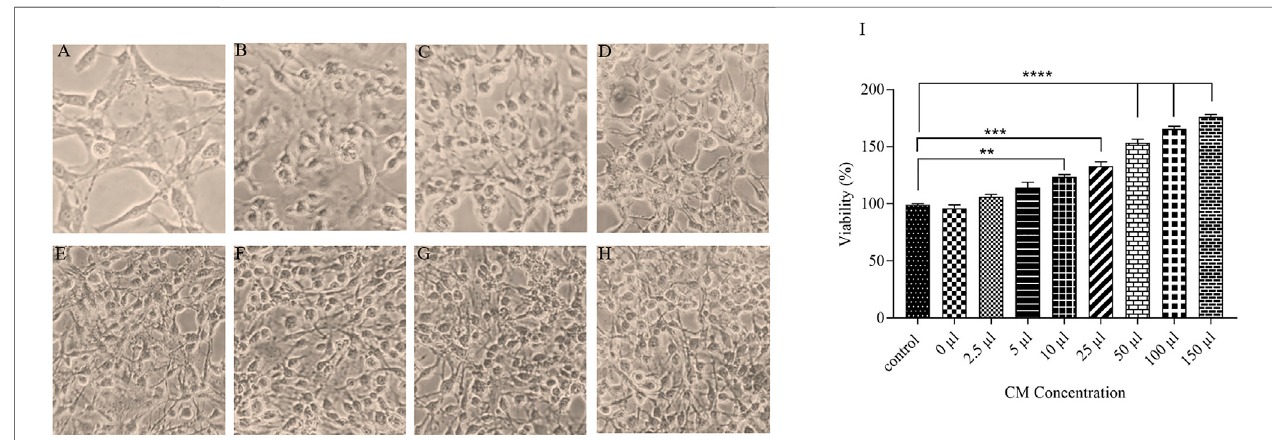
FIGURE 5 | A microscopic image ofOLN-93 groups treated with different concentrations of CM (A) : Control, (B) :2.5 µl, (C) :5 μ l, (D) :10 μ l, (E) :25 μ l, (F) :50 μ l, (G) : 100 μ l, and (H) :150 µl. (I) After treatment ofoligodendrocytes with the CMfor 7 days, cell survivalwasincreased in all evaluated concentrations(** p < 0.01, *** p < 0.001 and **** p <